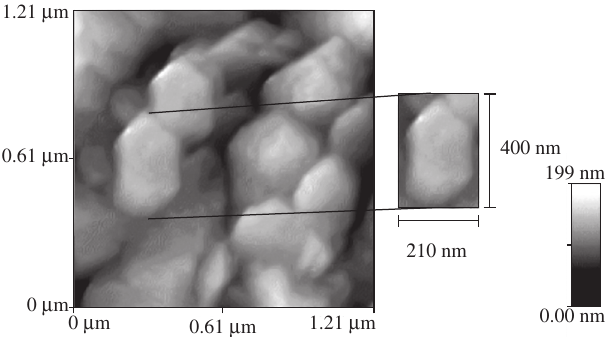
Figure 3. AFM micrograph of powder calcined at 950 °C in inert atmosphere (X 50000).